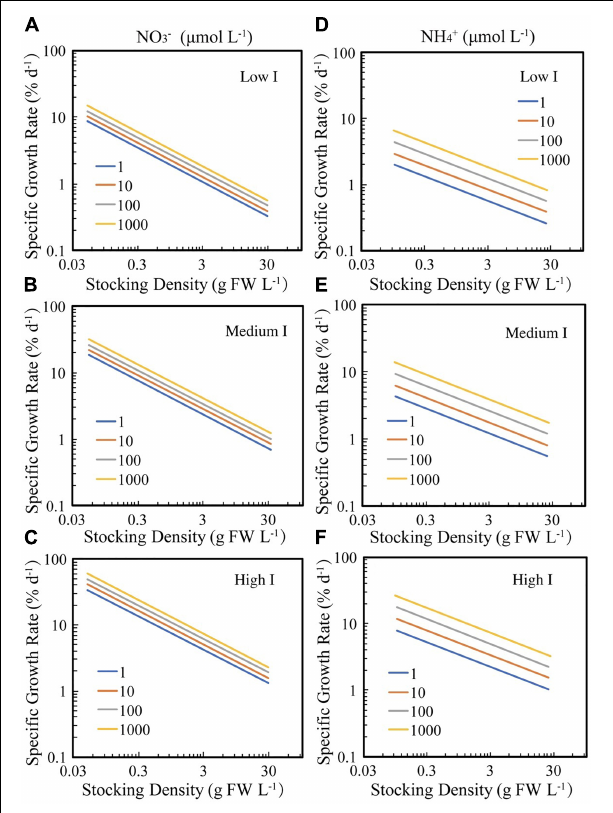
FIGURE 3 | The fitted relationships between SGR and BD for seaweed growing under experimental or culture conditions under different irradiance (I), ammonia (NH 4 + ), and nitrate (NO 3 − ) concentrations. The solid lines correspond to the fitted general linear models log 10 SGR = –0.03–0.51 ( ± 0.04) log 10 BD + 0.08 ( ± 0.02) log 10 NO 3 + 0.30 ( ± 0.05) log 10 I ( R 2 = 0.39, F = 74.16, N = 349, P < 0.0001), and log 10 SGR = –0.37–0.37 ( ± 0.04) log 10 BD + 0.17 ( ± 0.03) log 10 NH 4 + 0.30 ( ± 0.05) log 10 I ( R 2 = 0.33, F = 44.4, N = 275, P < 0.0001), respectively. Low I, medium I and high I are 10, 125, and 1000 µ m photon m − 2 s − 1 , respectively, which are the 2.5, 50, and 97.5% quantiles of the irradiance data. (A–C) Seaweed growth in response to nitrate (NO 3 − ), under low, medium and high irradiance, respectively; (D–F) seaweed growth in response to ammonia (NH 4 + ), under low, medium and high irradiance,